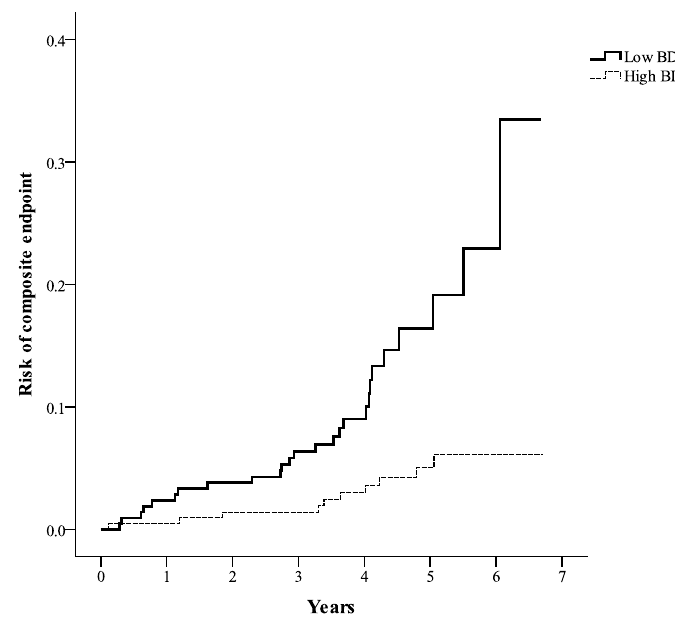
Figure 4. Kaplan–Meier curves showing the composite endpoint of all-cause mortality, nonfatal myocardial infarction, and nonfatal stroke in the high BDNF group and the low BDNF group (log-rank test, p < 0.001). BDNF = serum brain-derived neurotrophic factor. Table 4. Cox proportional hazards regression analyses for the effects of the associated risk factors on the composite endpoint of all-cause mortality, nonfatal myocardial infarction, and nonfatal stroke.